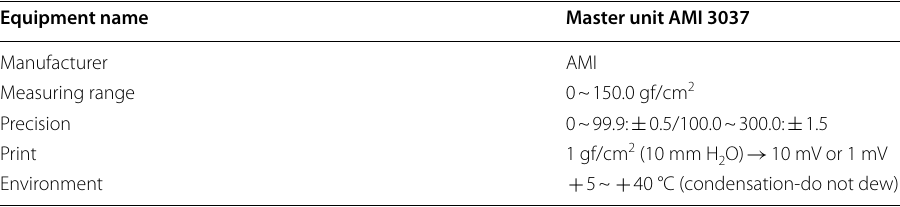
Table 4 Apparatus for measurement clothing pressure Equipment